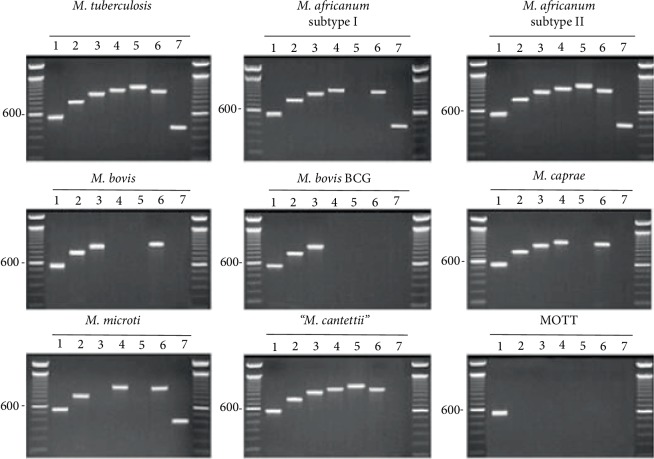
Result interpretation reference diagram for multilocus PCR.